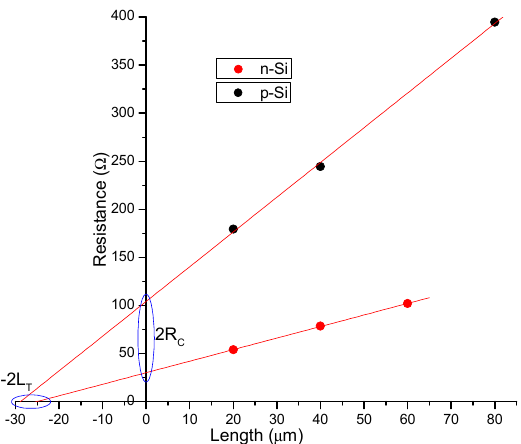
Figure A1. Contact resistance measurements using the transmission line method.